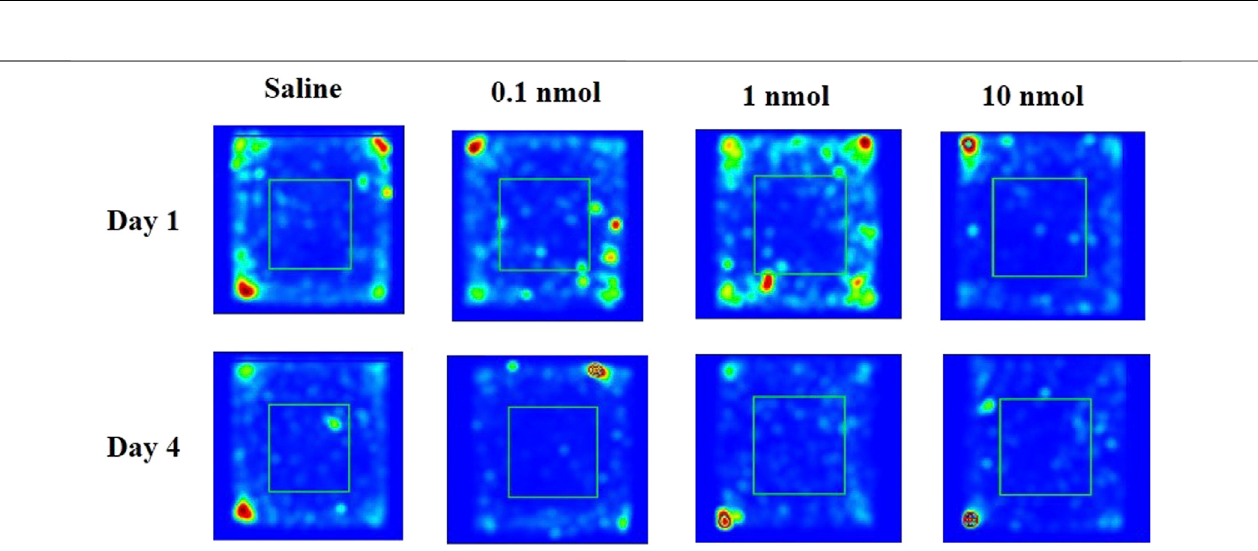
FIGURE 9 | The traces of mouse injected with saline or TxIB during locomotor activity